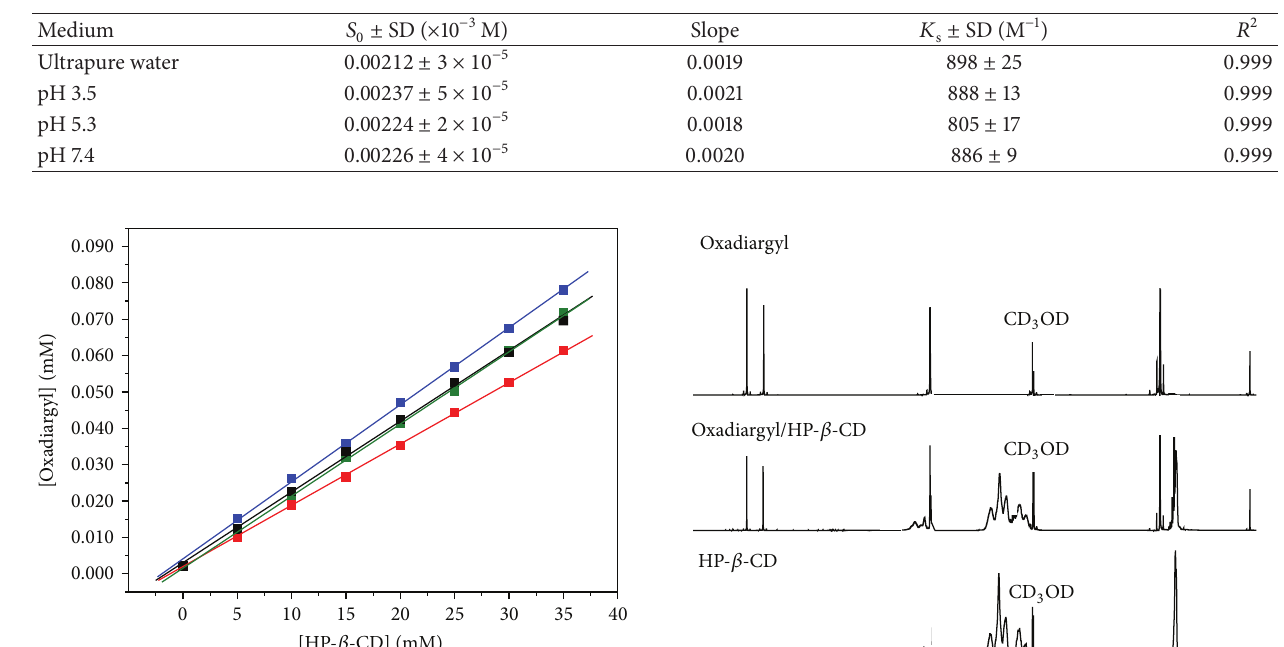
), and correlation coefficient. s